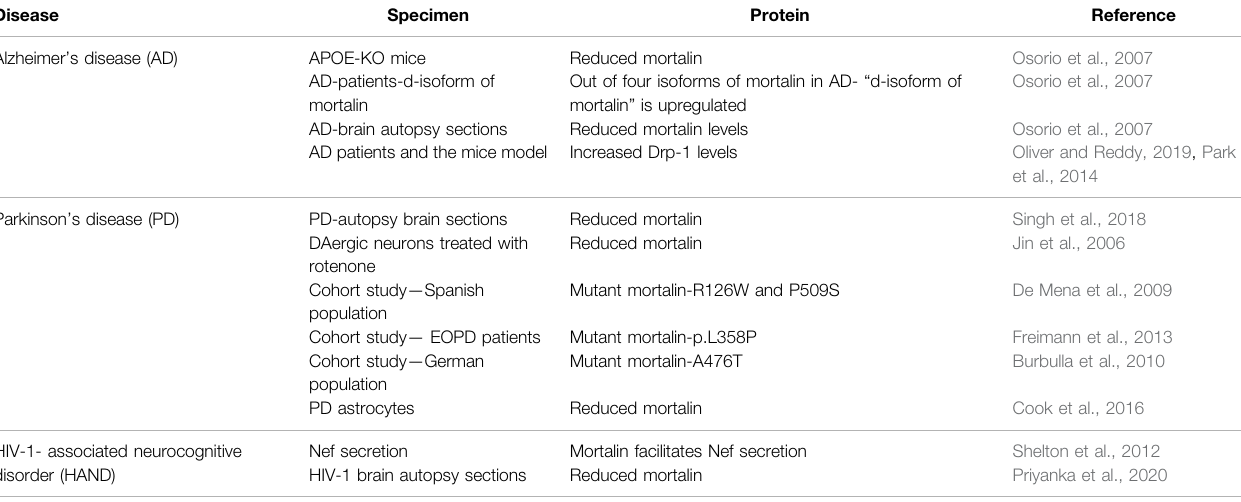
TABLE 1 | Tabular overview of proteins modulated in Alzheimer ’ s disease, Parkinson ’ s disease, and HIV-1-associated neurocognitive disorder (HAND). Disease